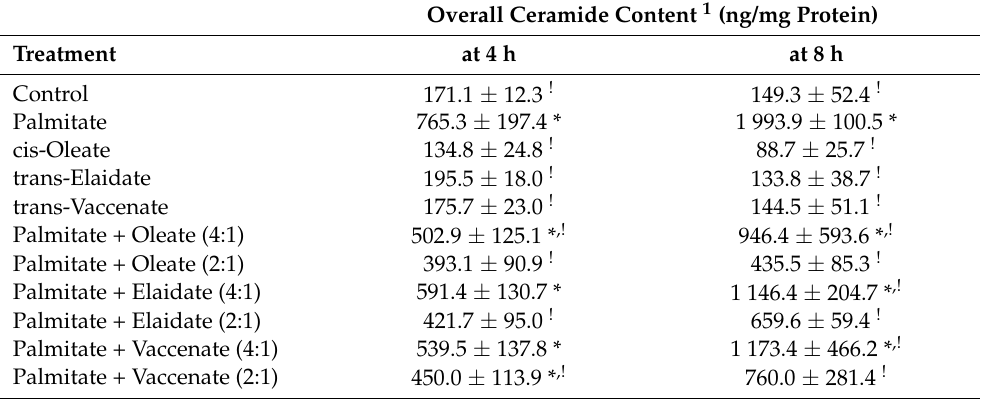
Table 4. Overall ceramide content of hepatoma cells in lipotoxicity. Cells were treated with BSA- conjugated palmitate, oleate, elaidate or vaccenate (800 µ M) or with palmitate (800 µ M) and oleate, elaidate or vaccenate at a 4:1 or 2:1 molar ratio (200 or 400 µ M) at 70–80% confluence for 4 or 8 h. The overall amount of three relevant ceramides was measured by LC-MS/MS. Data were normalized to the total protein content of the samples and are shown as mean values ± S.D.; n ≥ 4; statistically significant differences: * p < 0.05 vs. BSA treated control; ! p < 0.05 vs. palmitate treated